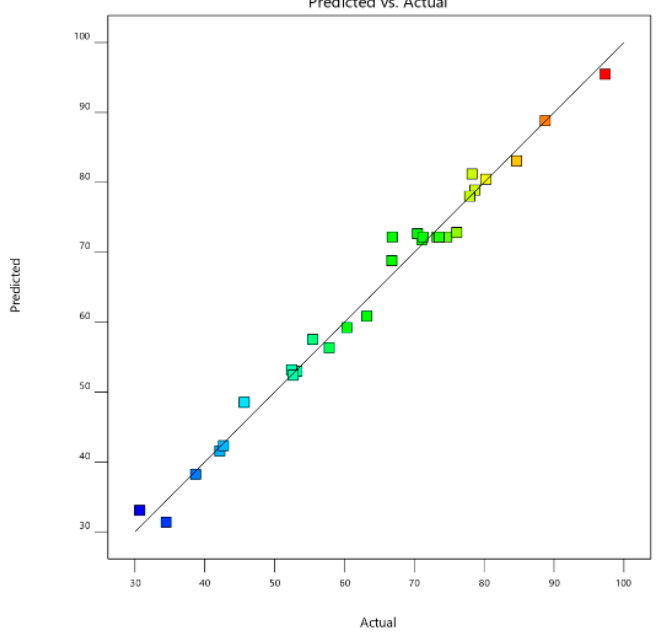
Figure 6. Actual values versus predicted response by CCD.